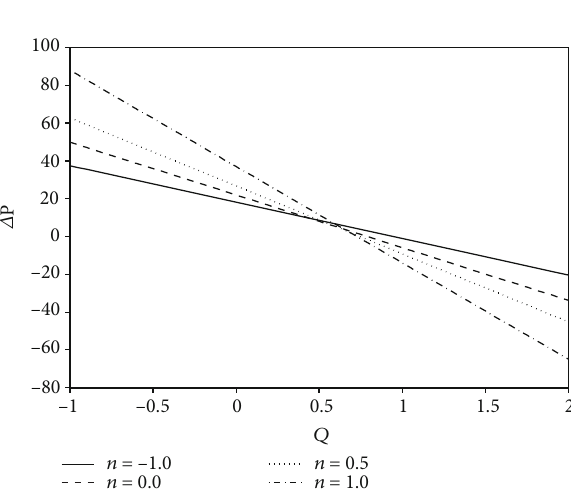
Figure 1: Variation of pressure rise with volume fl ow rate Q for di ff erent values of β for fi xed values of φ = 0 : 7 , We = 0 : 5 , and n = 0 : 6 .